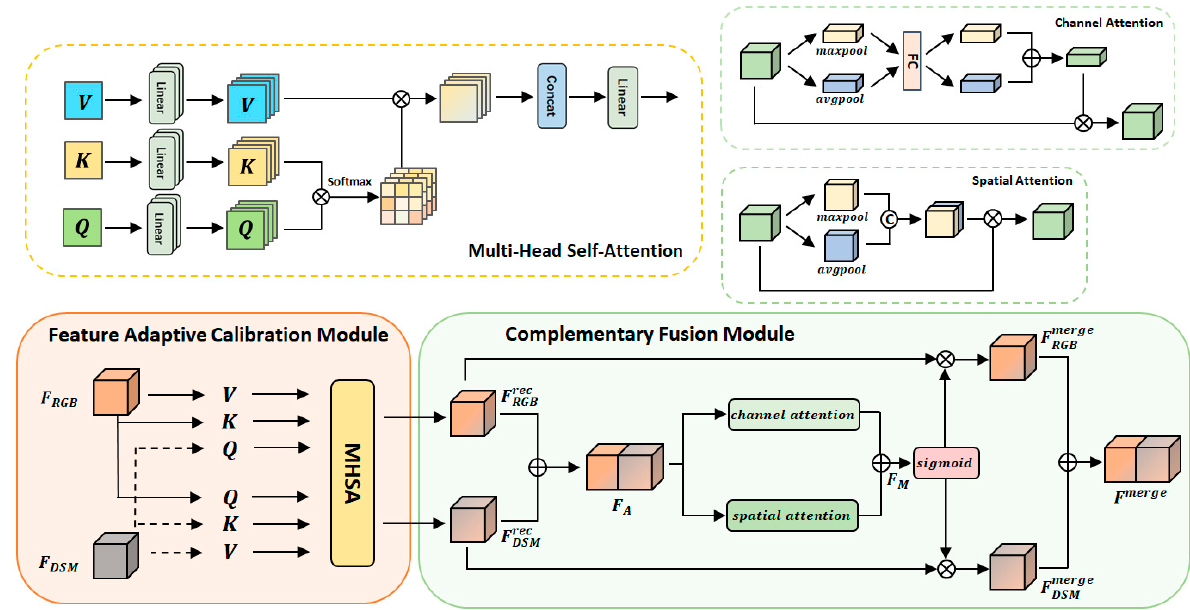
Figure 5. Diagram of the multi-head feature fusion module.